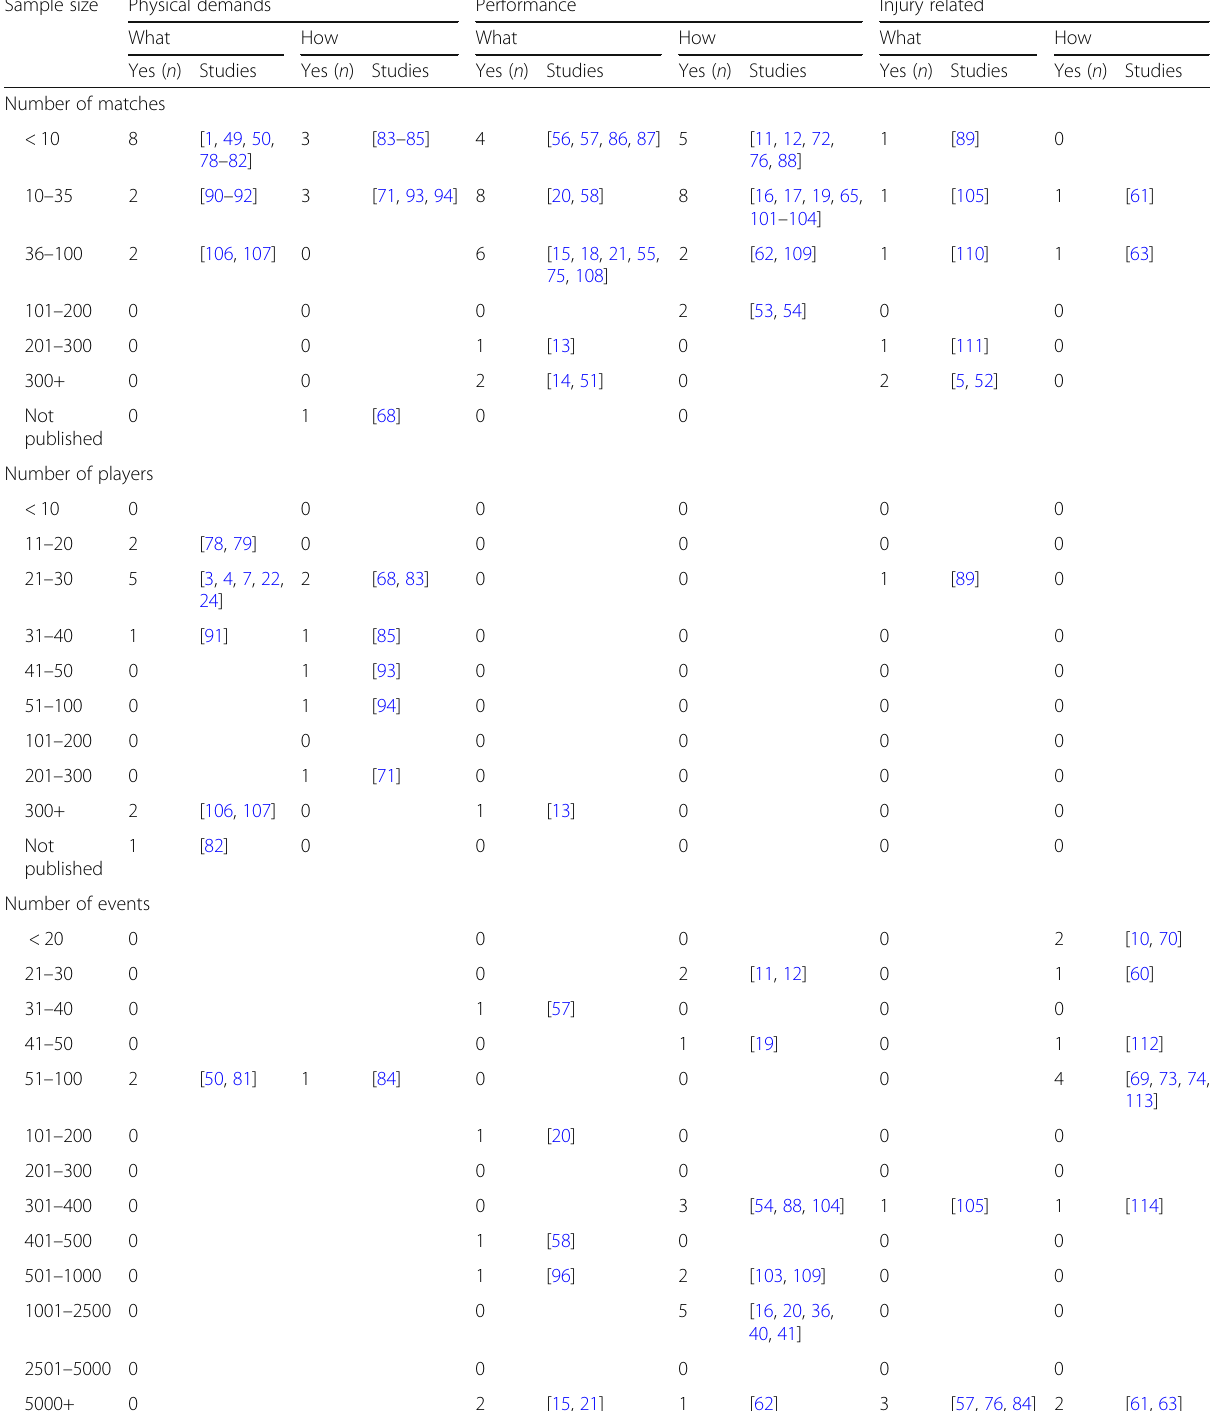
Table 2 A summary of the sample sizes Sample